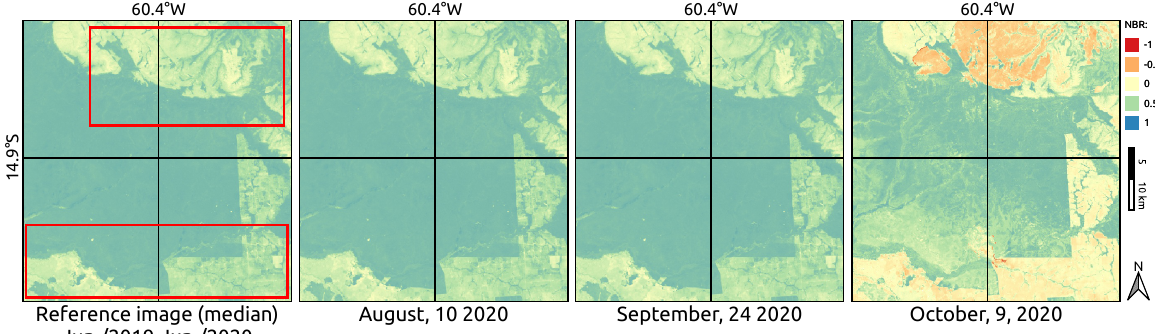
Figure 8. The NBR behavior for the reference image and individual instants regarding Area 2. Regions delimited by red rectangles highlight places with potential changes over